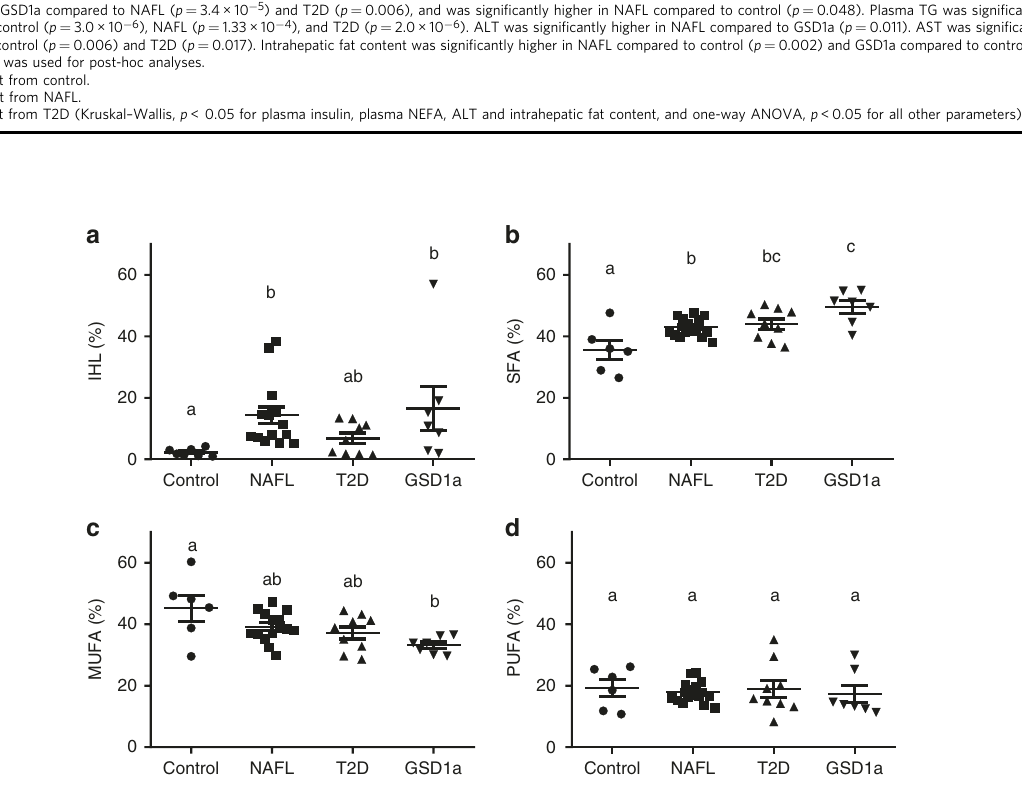
Fig. 6 Liver fat content and composition in groups with different metabolic disorders. Comparisons between overweight/obese controls without NAFL (controls, n = 7 for total liver fat content, n = 6 for liver fat composition), overweight/obese with NAFL (NAFL, n = 15), patients with type 2 diabetes (T2D, n = 9) and GSD type 1a (GSD1a, n = 7). a Total liver fat content in control, NAFL, T2D, and GSD1a. Total liver fat content was signi fi cantly higher in the NAFL group compared to the control group ( p = 0.002) and in the GSD1a group compared to the control group ( p = 0.027). b SFA fraction in control, NAFL, T2D, and GSD1a. SFA fraction was signi fi cantly higher in the GSD1a group compared to the control group ( p = 7.3 × 10 − 5 ) and NAFL group ( p = 0.034), signi fi cantly higher in the T2D group compared to the control group ( p = 0.016), and signi fi cantly higher in the NAFL group compared to the control group ( p = 0.022). c MUFA fraction in control, NAFL, T2D, and GSD1a. MUFA fraction was signi fi cantly lower in the GSD1a group compared to the control group ( p = 0.006). d PUFA fraction in control, NAFL, T2D, and GSD1a. Data are presented as mean with error bars showing the SEM. Different letters indicate signi fi cant differences between groups (Kruskal – Wallis, p < 0.05 for IHL and PUFA, and one-way ANOVA, p < 0.05 for SFA and MUFA). Bonferroni correction was used for post-hoc